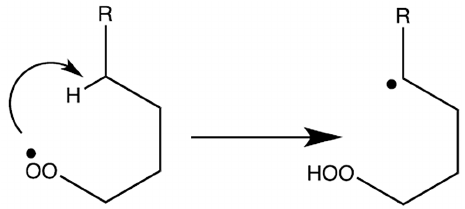
Figure 39. RO 2 isomerisation to QOOH. In this mechanism, well known in combustion chemistry, the terminal O atom of the RO 2 abstracts a labile H (through the formation of a ring-structured in-